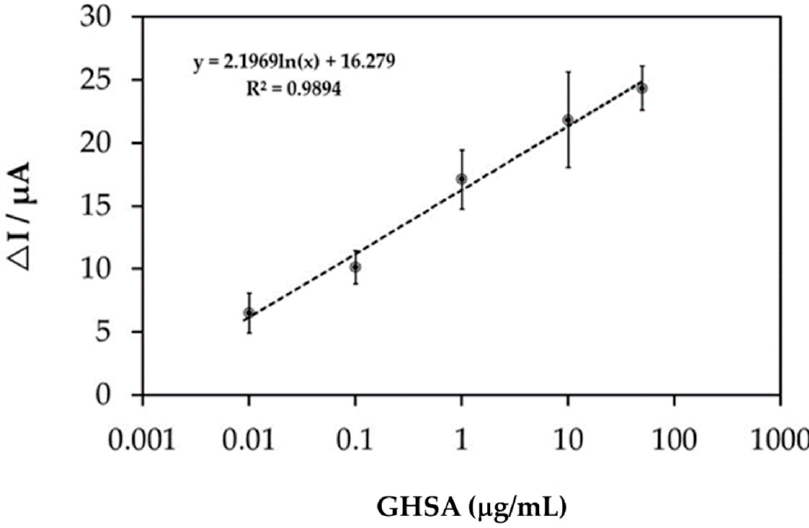
Figure 5. The calibration curve of the GHSA concentration on a base-10 logarithmic scale, for which y = 2.1969ln(x) + 16.279 and R 2 = 0.9894. Δ I represents the current change.